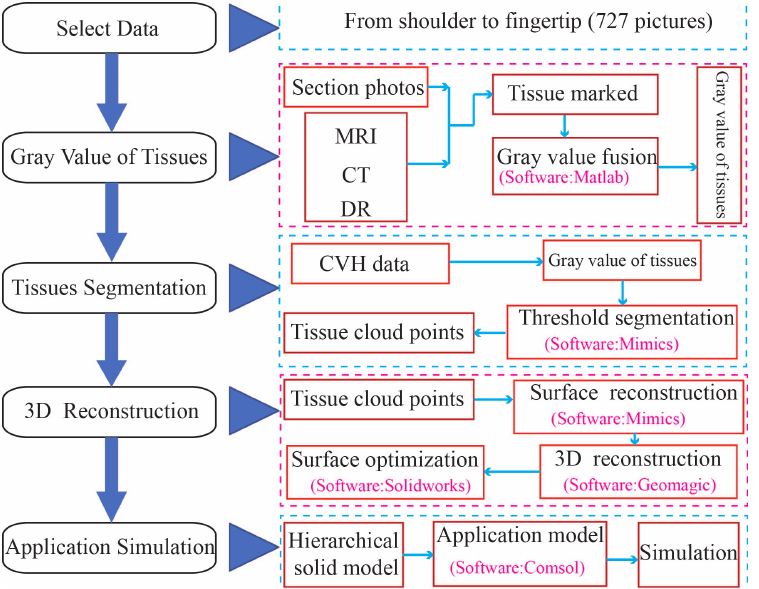
Figure 1. The flowchart for the 3D reconstruction of the Chinese digital arm (CDA)-based Chinese Visible Human (CVH). MRI, magnetic nuclear resonance; CT, computerized tomography; DR, Digital